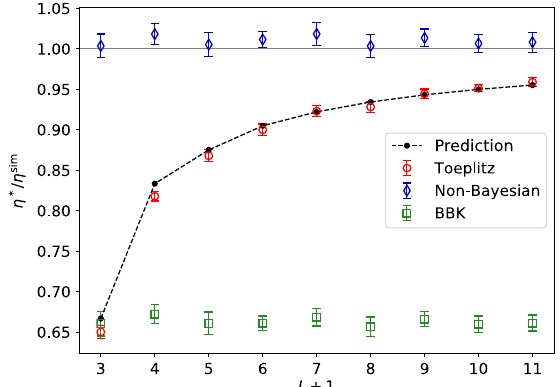
FIG. 4. Numerical validation of the finite-size distortion in- troduced by the shift-invariant approximation. Black points connected by dashed lines represent the analytical prediction about the rescaling factor ϱ ð L þ 1 Þ ¼ η (cid:3) ð L þ 1 Þ = η sim , with ϱ ð L ¼ 3 Þ ¼ 2 = 3 (shortest possible trajectory) and ϱ ð L þ 1 Þ → 1 monotonically as L → ∞ . Numerical results are in agreement with this prediction. As expected, no dependence on the trajec- tory length is found for the non-Bayesian method nor for Euler- like methods (BBK used here — see Appendix B 1 for